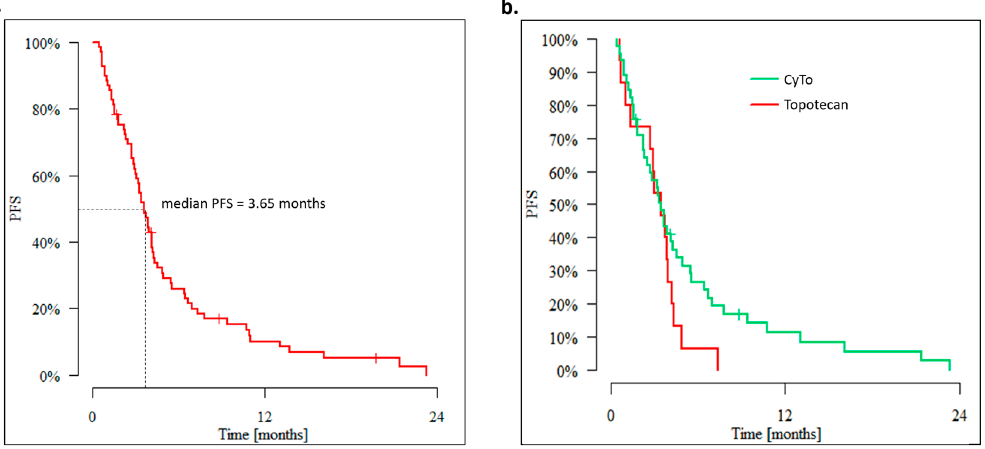
Figure 2. Progression-free survival ( a ) in the whole population; ( b ) in patients treated with single- agent topotecan and topotecan + cyclophosphamide (CyTo) combination.